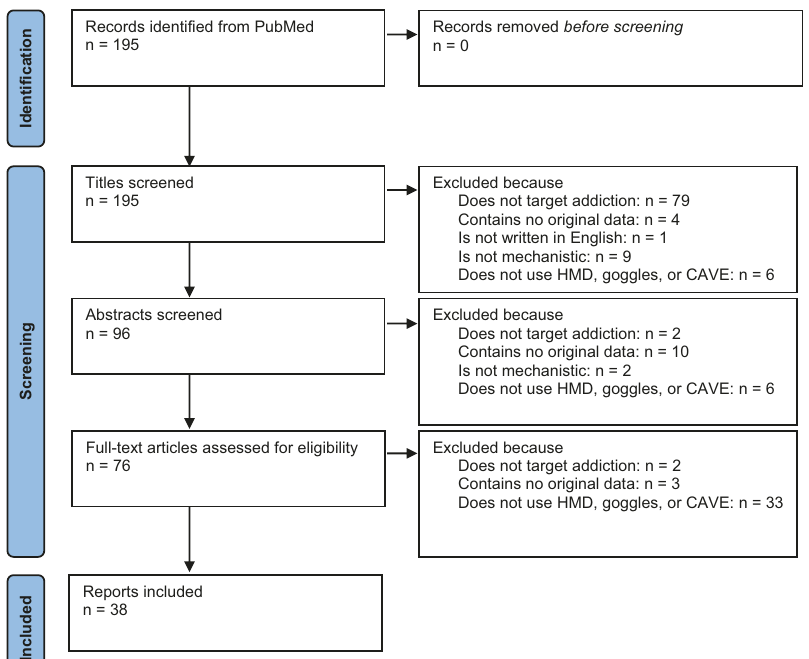
Fig. 1 PRISMA fl ow diagram of the study selection process. It illustrates the numbers of records identi fi ed, excluded and included, and reasons for exclusions. HMD head-mounted